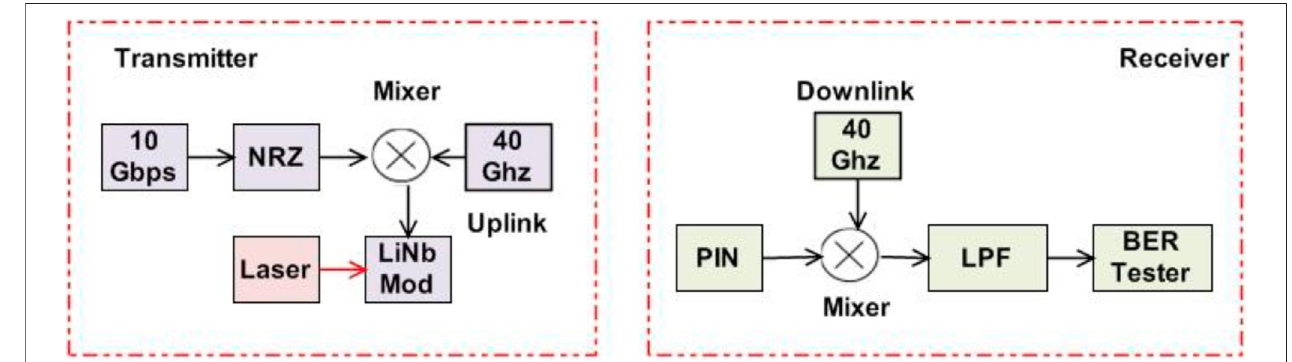
FIGURE 4 | Schematic representation of Transmitter and Receive. rThe FSO link can be mathematically described as.